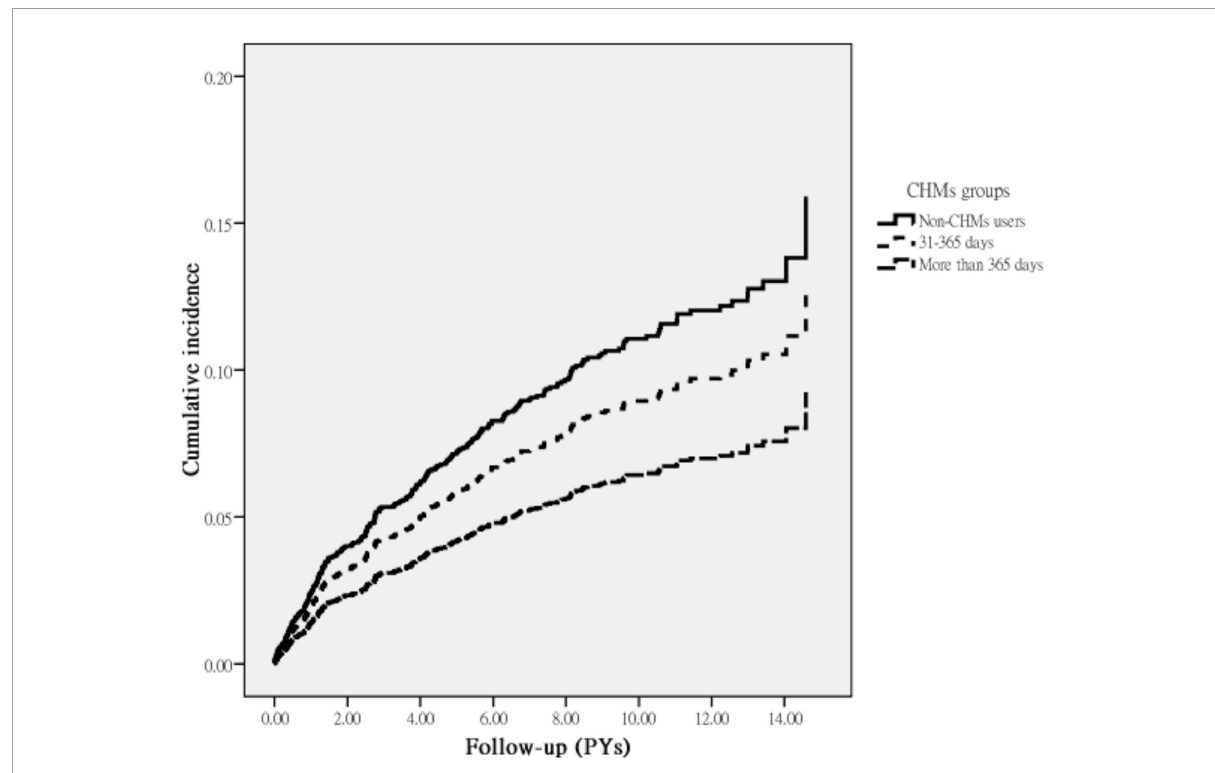
FIGURE2 Cumulative incidence of depression in breast cancer patients with and without receiving CHM treatment during the study period (Log-rank test, P = 0.02).